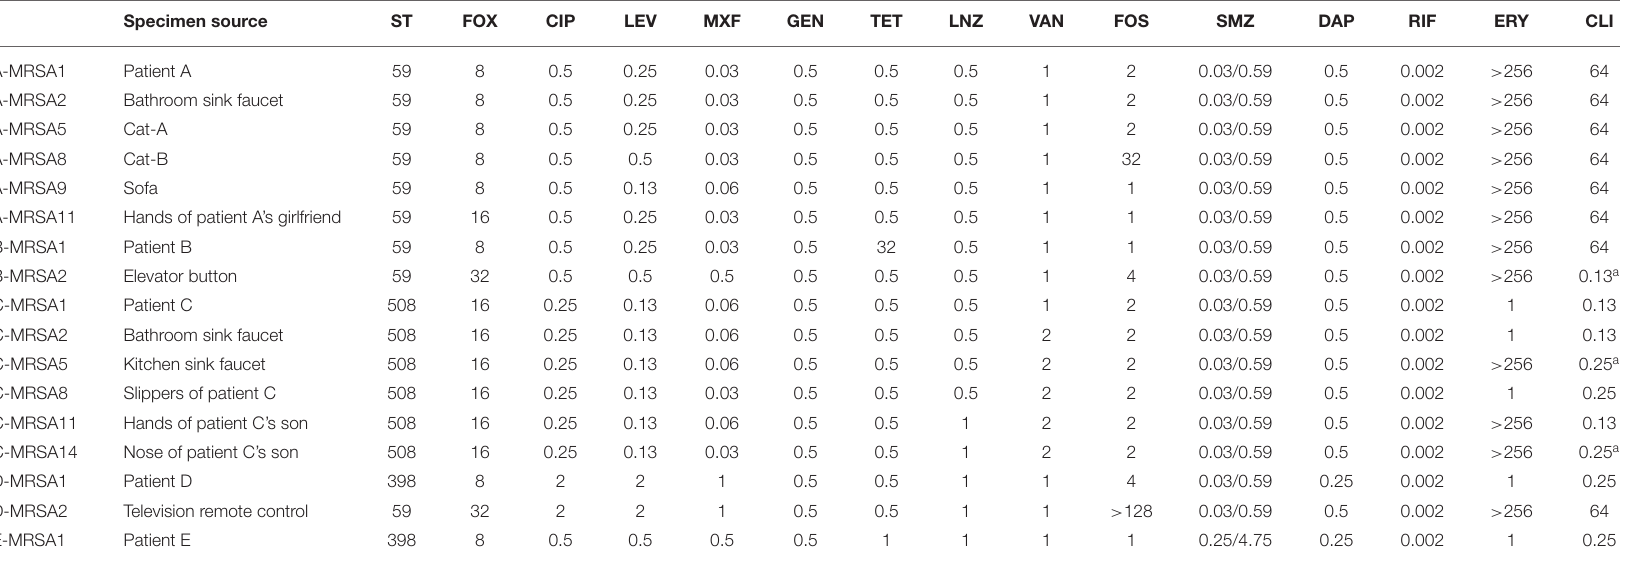
TABLE 2 | Minimum inhibitory antibiotic concentrations of MRSA isolates from patients and their households. Specimen